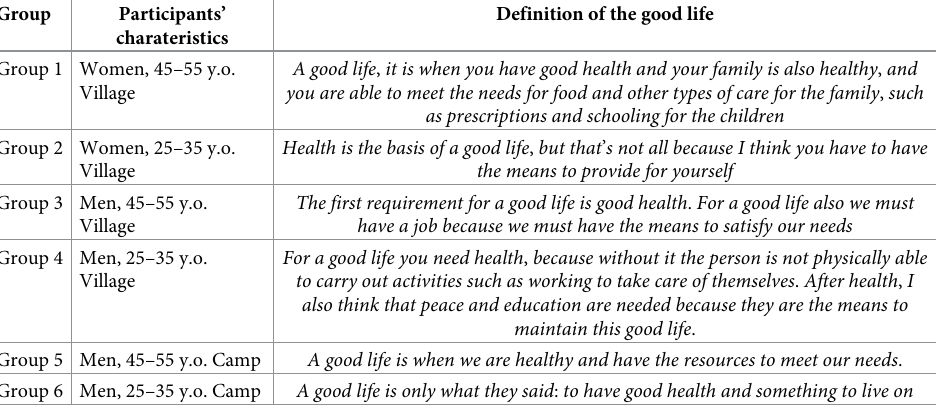
Table 1. Main definitions of the good life among focus